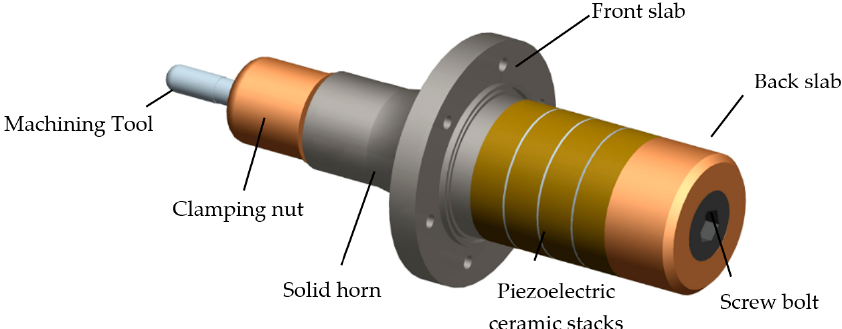
Figure 1. Mechanical structure of ultrasonic transducer.